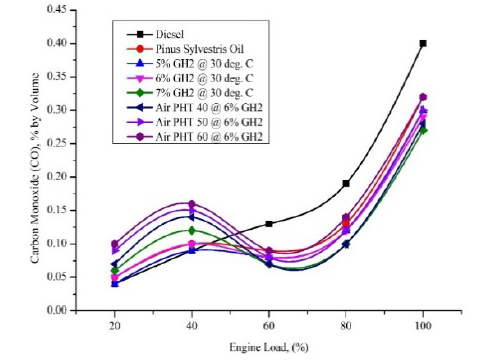
Figure 8 HC Vs. Engine